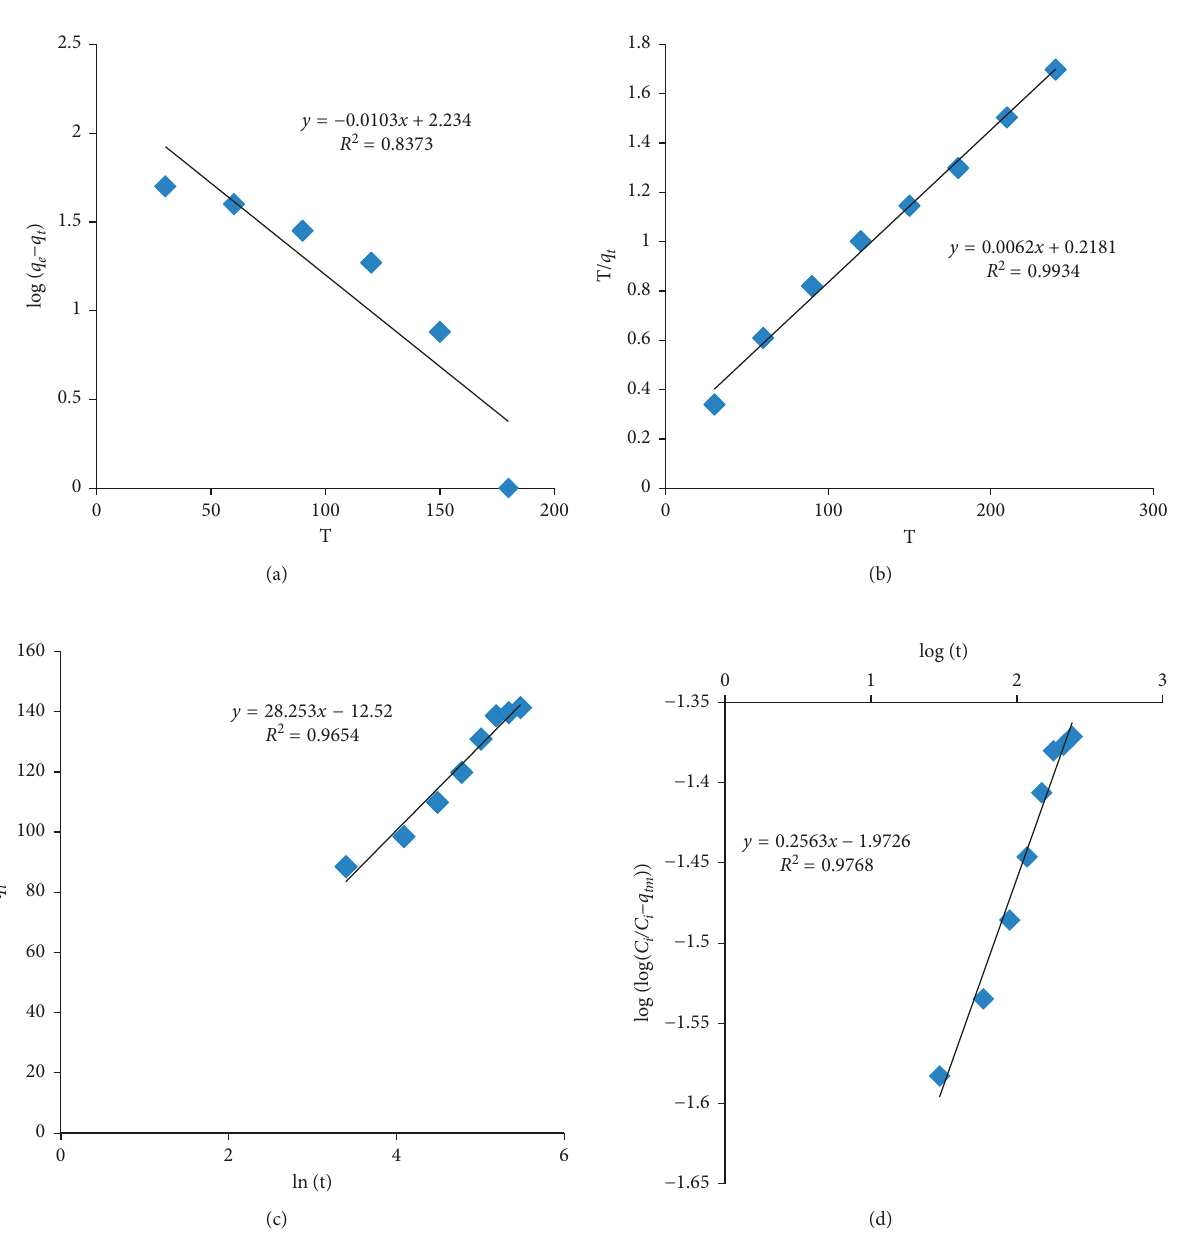
Figure 14: (a) Pseudo-first-order kinetics. (b) Pseudo-second-order kinetics. (c) Elovich model. (d) Bangham’s pore diffusion